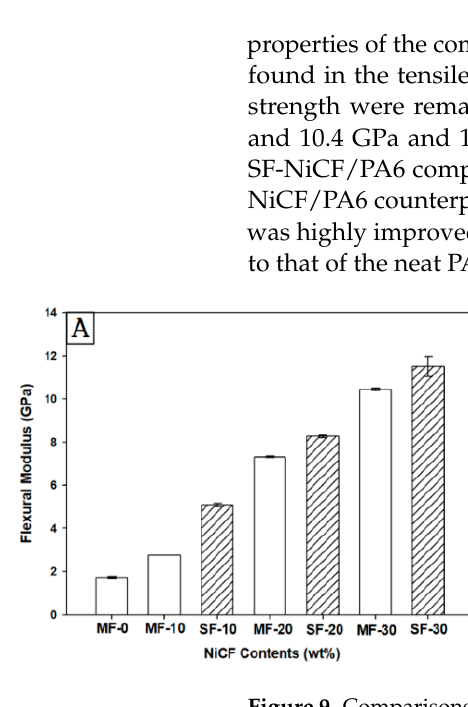
Figure 9. Comparisons of ( A ) the flexural modulus and ( B ) the flexural strength of the MF-NiCF/PA6 and SF-NiCF/PA6 composites with various NiCF contents.